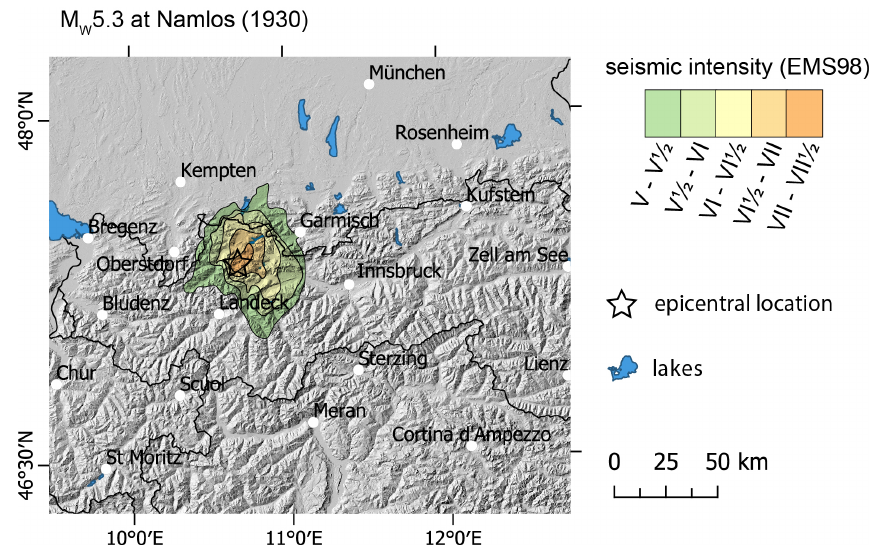
Figure 2. Isoseismal map of the historical M w 5.3 Namlos earthquake in 1930 based on historical intensity data points (Oswald et al., 2021b).